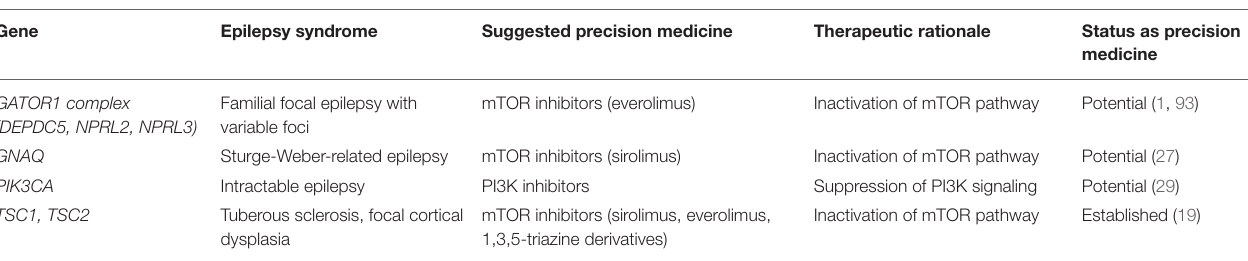
TABLE 2 | Inhibitors of cellular